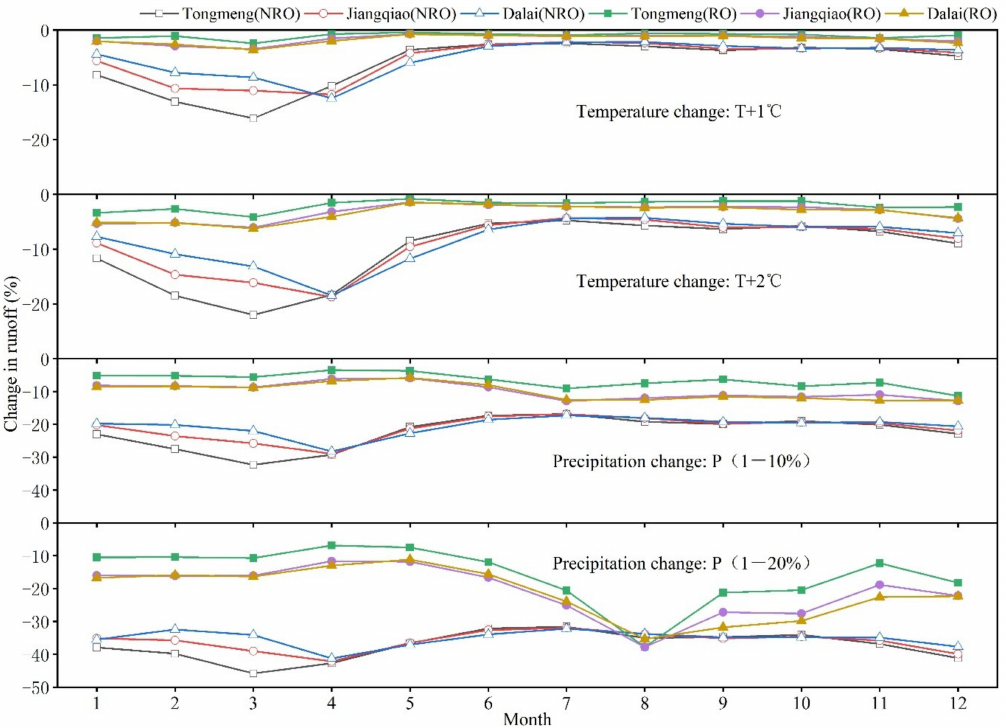
Figure 10. The change of mean monthly runo ff under temperature or precipitation